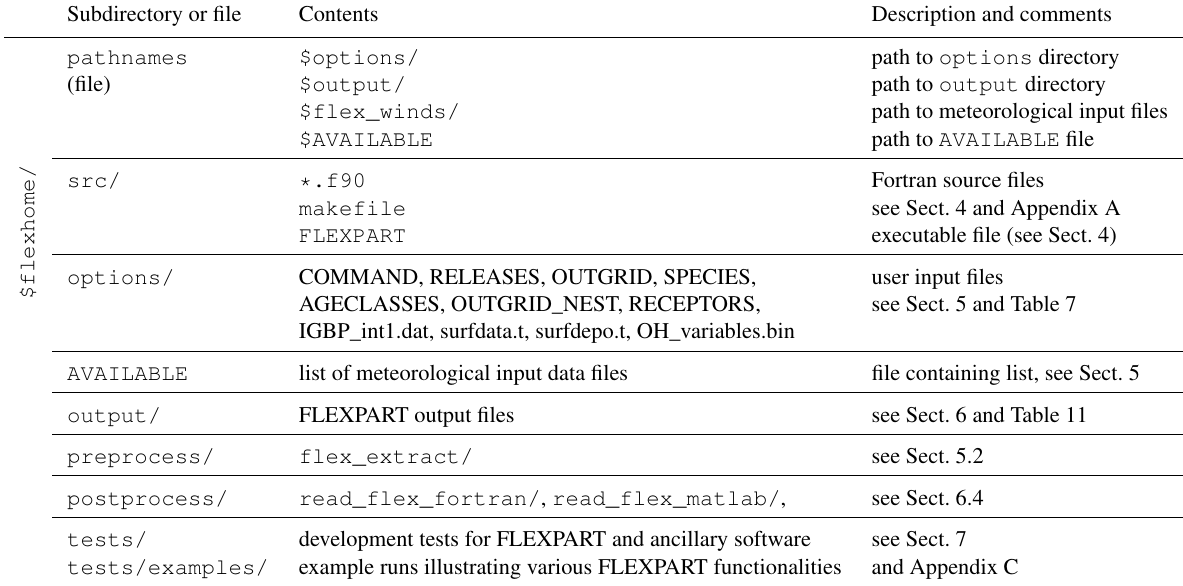
Table 1. Directory structure overview of the FLEXPART v10.4 software distribution. All listed directories are subdirectories of the installa- tion root directory $flexhome/